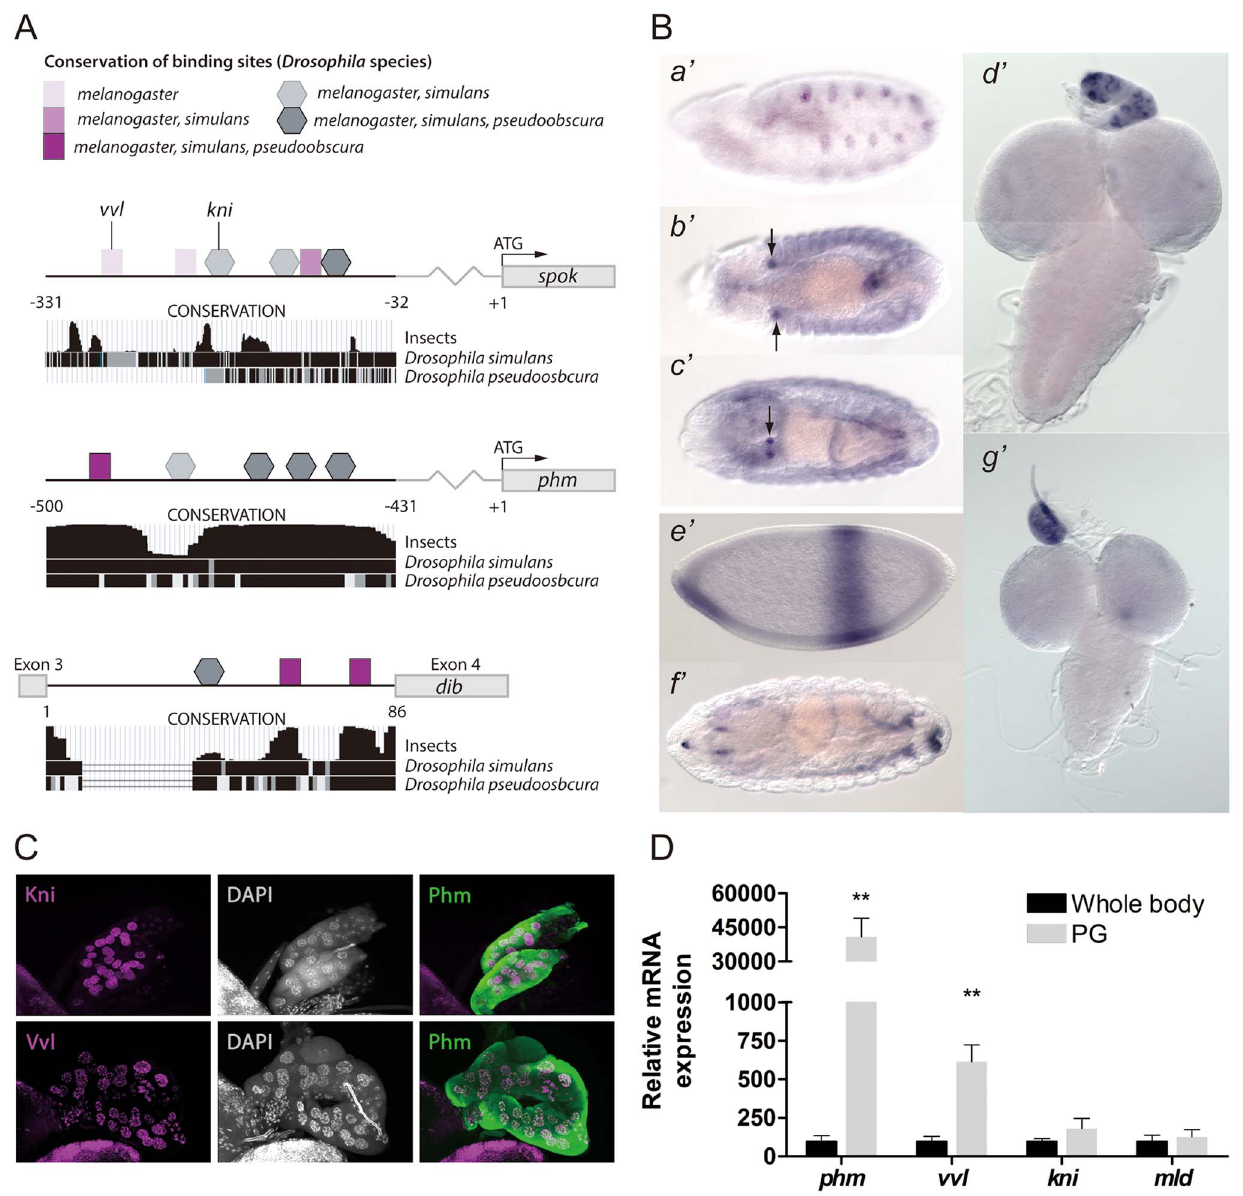
Figure 1. Vvl and Kni have binding sites in the promoters and enhancers of the ecdysone biosynthetic genes and are expressed in the PG. (A) An illustration showing binding sites in the PG specific cis-regulatory elements of spok and phm and dib . Binding sites are indicated by squares (Vvl) and pentagons (Kni) with shades indicating the conservation of the site between Drosophila species. Conservation tracks were obtained from the UCSC genome browser. (B) In situ hybridization of embryos and third instar larval brains and ring glands with antisense probes for vvl ( a 9 – d 9 ) or kni ( e 9 – g 9 ). ( a 9 ) Stage 11, shows vvl expression in the primordial cells of the trachea, while ( b 9 ) stage 13, ( c 9 ) stage 16 and ( d 9 ) L3 show strong vvl expression in the PG cells of the ring gland. ( e 9 ) stage 4, ( f 9 ) stage 16 and ( g 9 ) L3 show kni expression in the PG of L3 larvae, but not clearly in embryos. (C) Immunostaining of the PG from L3 larvae with antibodies against Kni and Vvl (magenta) and Phm (green). Co-localization with nuclei staining (DAPI: gray) indicates that Vvl and Kni are expressed in the nucleus of the PG cells. (D) Expression of phm , vvl , kni and mld measured by qPCR in tissue from whole body L3 larvae or dissected ring glands containing the PG of L3 larvae (n=4). vvl is highly expressed in the ring gland compared to whole body, like phm , while the expression of kni and mld show a minor enrichment in the gland. Error bars indicate s.e.m. ** P , 0.01, versus whole